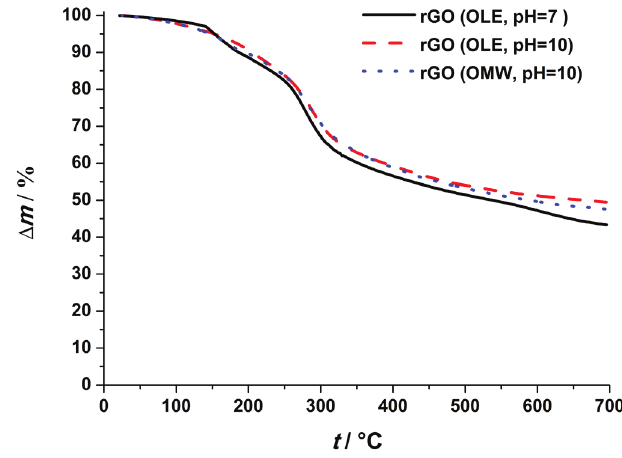
Fig. 3 – Thermogravimetry analysis of rGO Table 1 – Resistance and electrical conductivity values for the different rGO thin films Sample